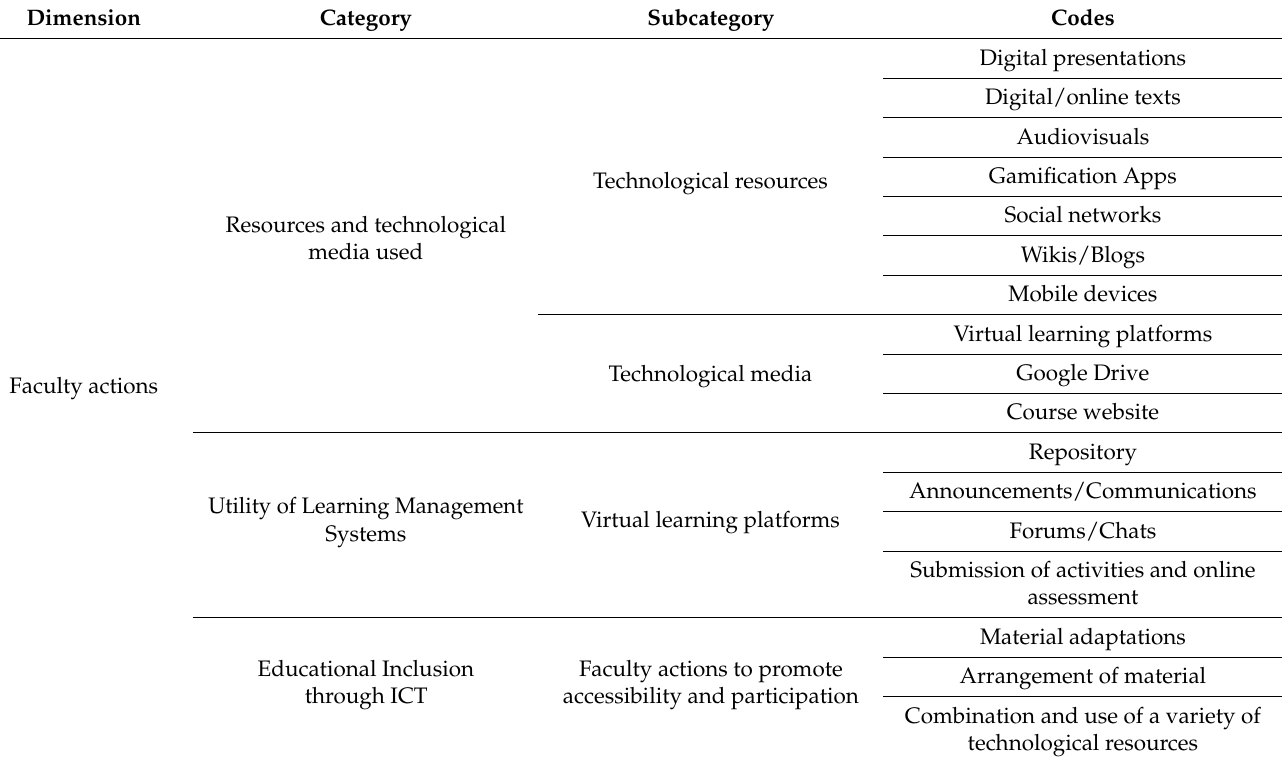
Table 2. System of categories and codes